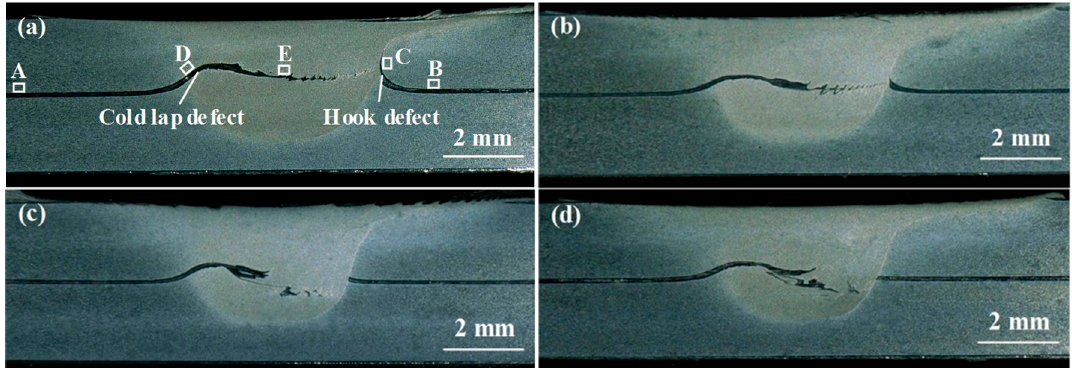
Figure 2. Cross ‐ sections of the lap joints obtained at different welding speeds: ( a ) 50 mm/min; ( b ) 100 mm/min; ( c ) 150 mm/min; ( d ) 200 mm/min; A–E marked in ( a ) reflect the locations where microstructure analyses were conducted.